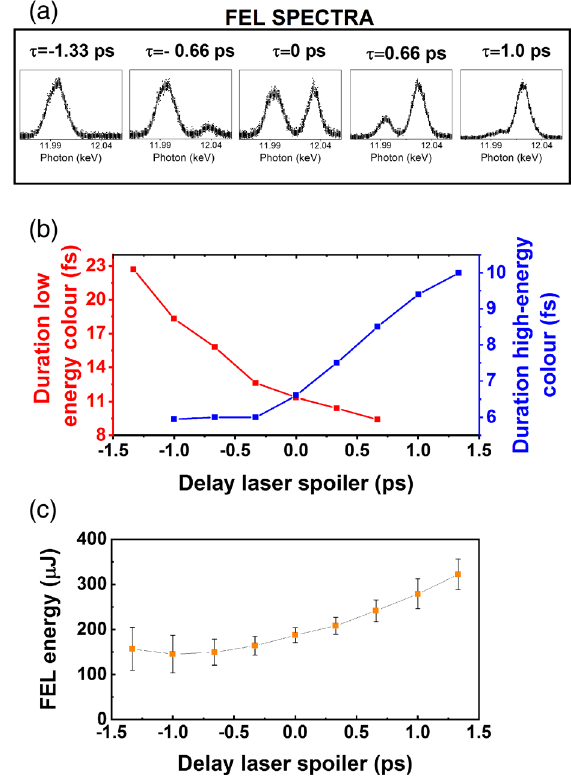
FIG. 5. (a) The two-color FEL spectra for different delays of the laser emittance spoiler, τ , indicated above each graph. (b) The FWHM duration of the individual color pulses as a function of τ is retrieved through statistical analysis of the spectra. The red and the blue curves refer to the pulse duration for the longer and shorter wavelength color. (c) the corresponding average and standard deviation of the total FEL